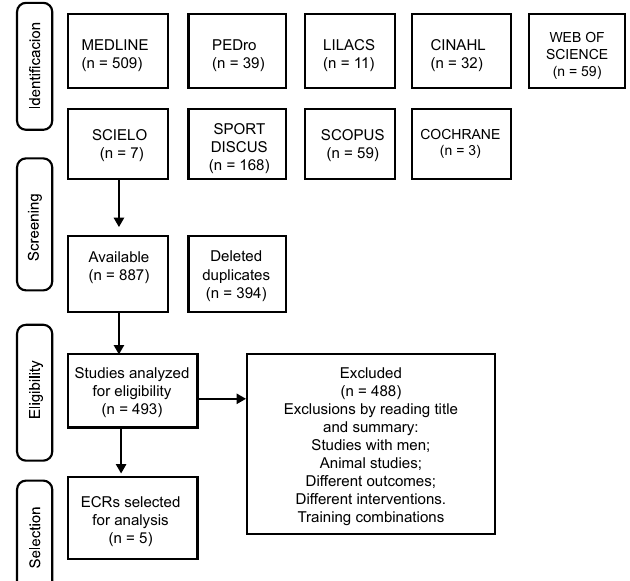
Figures: 2,3,4,5 - Forest Plot Table 2 - Methodological quality of the studies analyzed through the Jadad Scale Table 3 - Risk of Bias analysis through the Cochrane Collaboration Tool Figures: 6,7,8,9 - Funnel plot Table 4 - Level of evidence of the meta-analysis, according